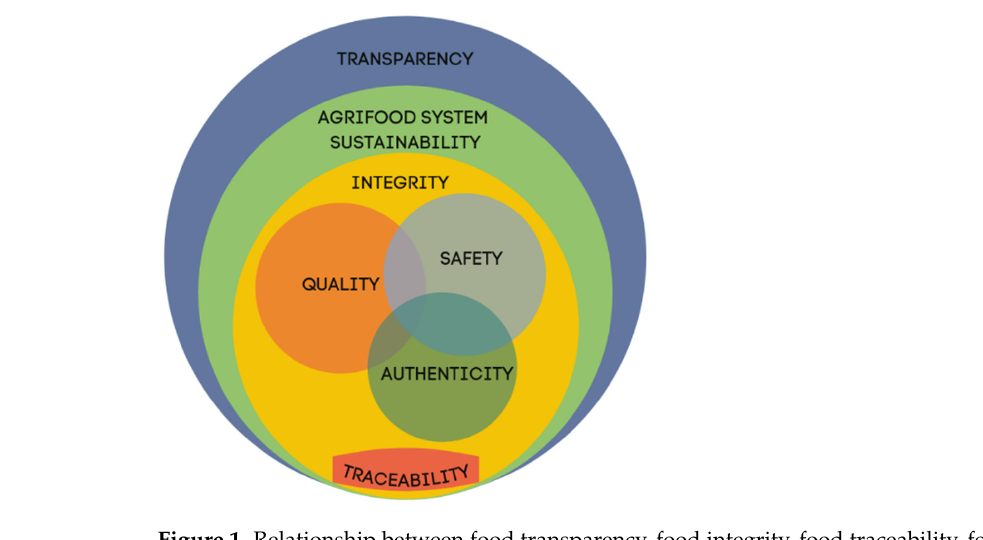
Figure 1. Relationship between food transparency, food integrity, food traceability, food quality, food safety, food authenticity and sustainability.